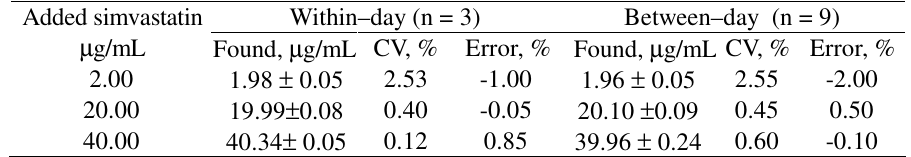
Table 3. Accuracy and precision data of determination of simvastatin (2-40 µ g/mL) in the presence of ezetimibe (10 µ g/mL) by first order derivative spectrophotometry